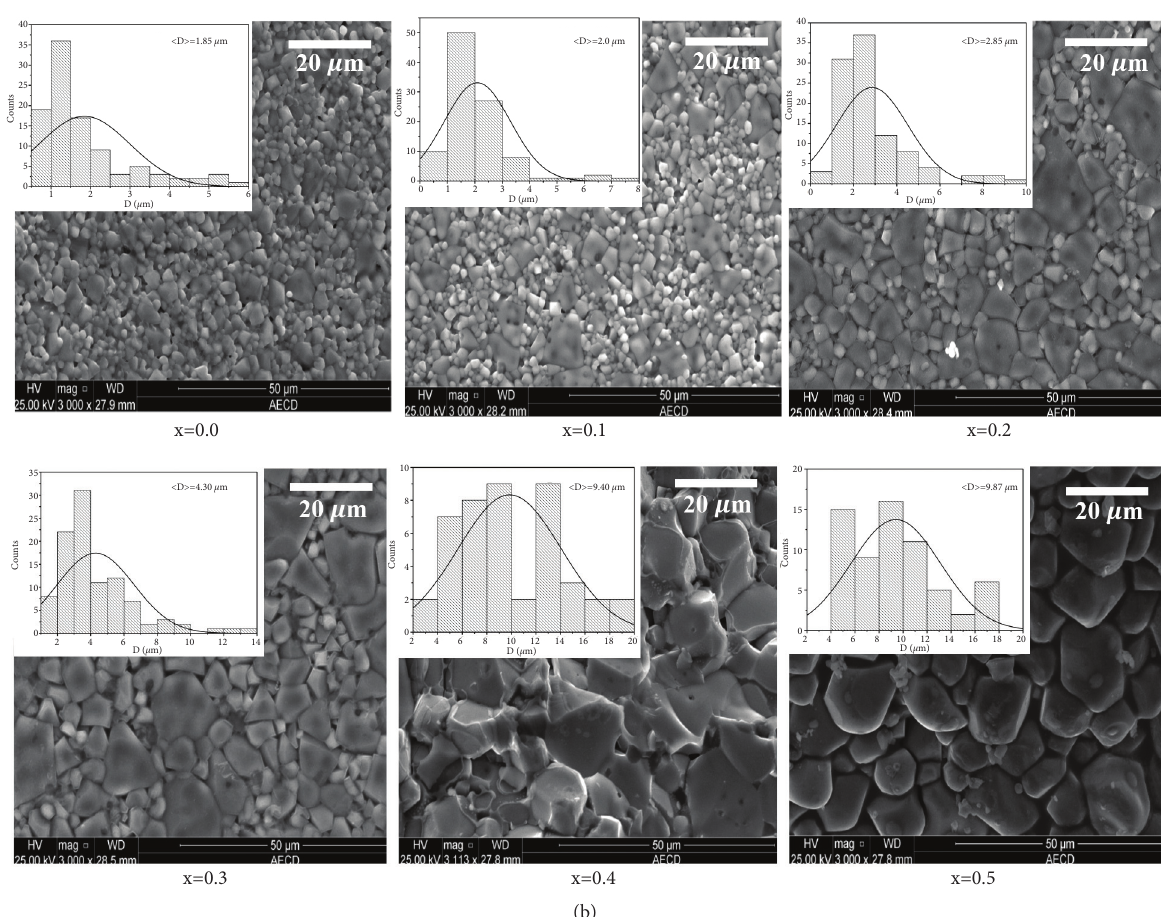
Figure 2: SEM micrograph of (a) furnace-cooled and (b) quenched Mg distribution fitted with lognormal